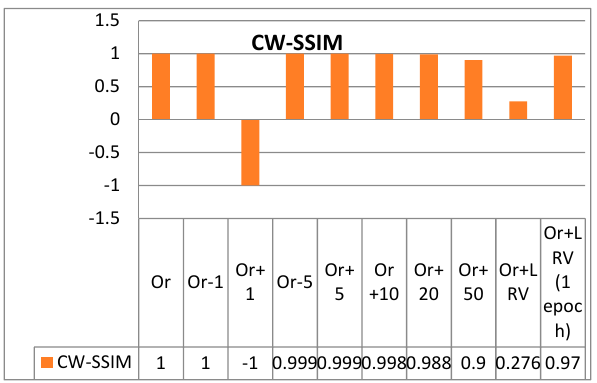
Figure 15. The effect of variation on CW-SSIM. Figure 15. The e ff ect of variation on